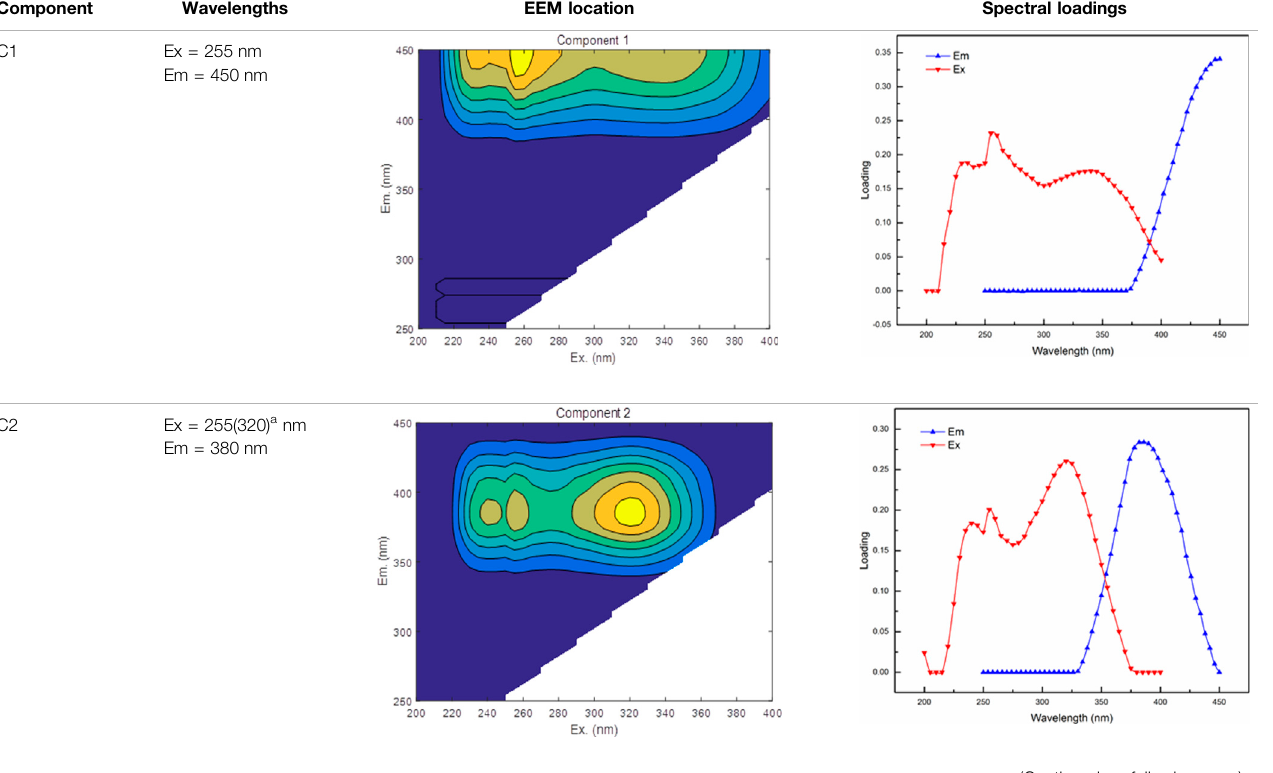
TABLE 4 | EEM locations, representative EEM contours, and fl uorescence spectral loadings of the six components identi fi ed by EEM-PARAFAC modeling.